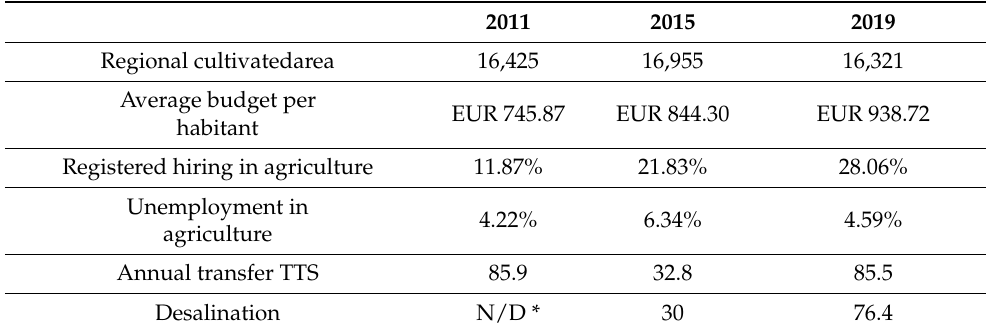
Table 12. Socio-economic indicators in the Vega Baja del Segura in relation to the greater or lesser availability of water